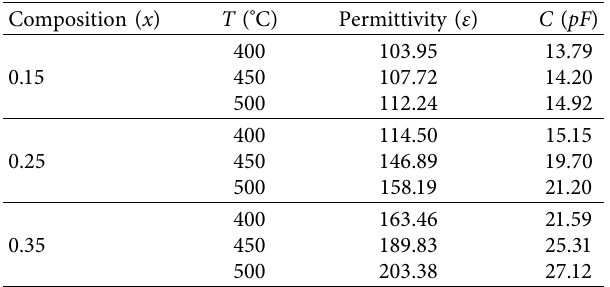
Figure 3: M ′ versus M ″ for (a) 0.85PMN-0.15KBT, (b) 0.75PMN-0.25KBT, and (c) 0.65PMN-0.35KBT compositions at different temperatures. Table 1: Permittivity ( ε ) and capacitance (C) of (1 − x ) PMN-( x ) KBT at various